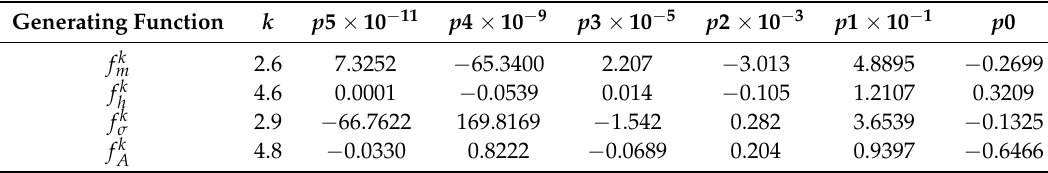
Table 1. Polynomial coefficients of the optimal generating functions.